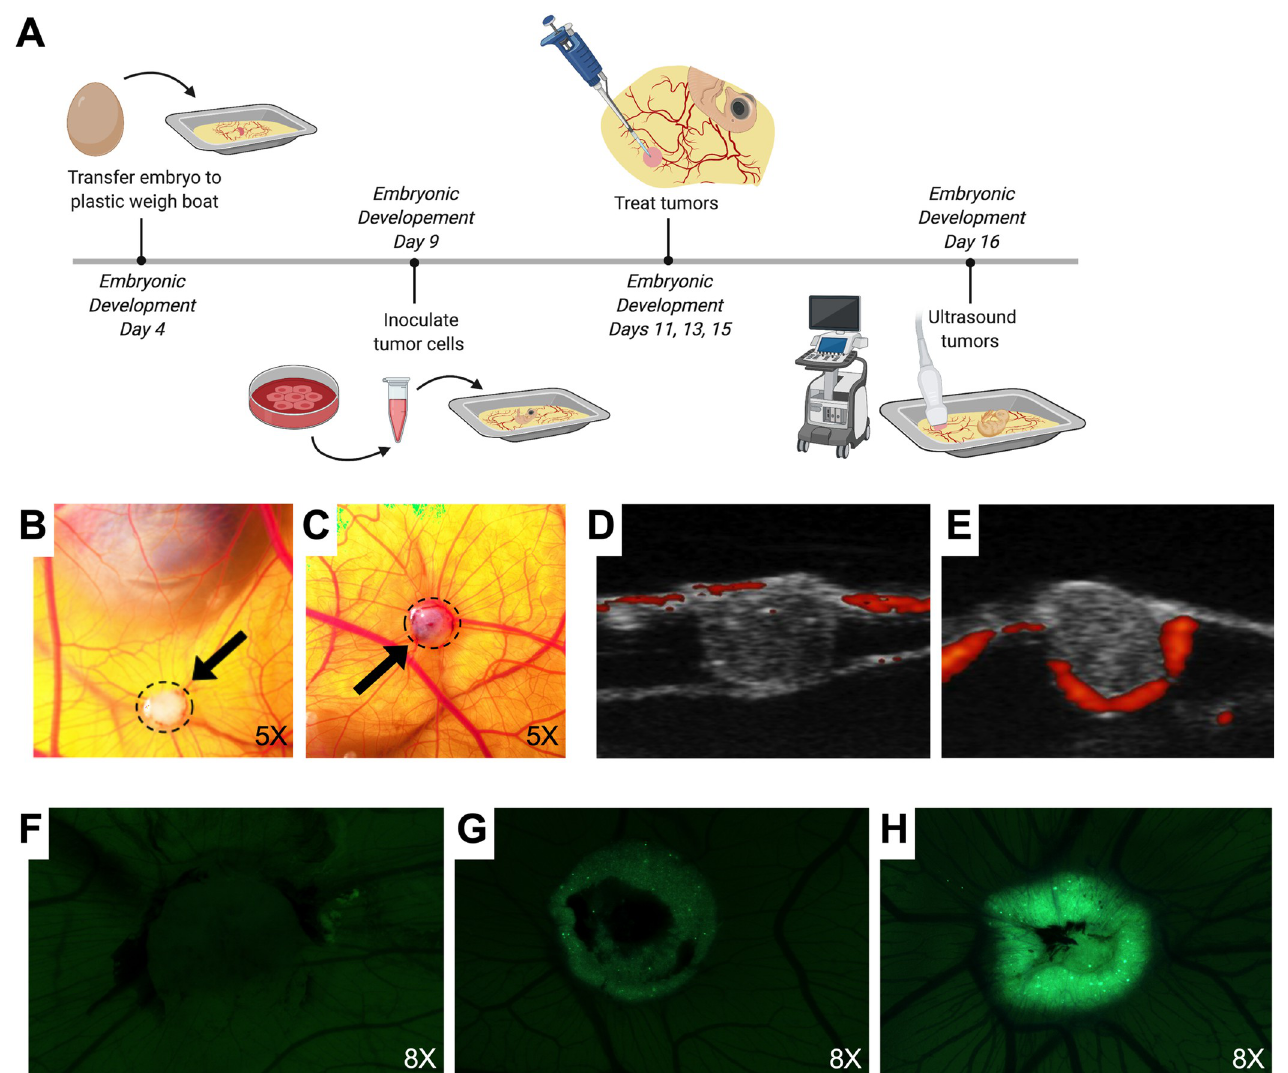
Fig 1. DIPG xenograft tumors are produced in the CAM model following inoculation with patient-derived cell lines. (A) Experimental procedures follow the corresponding timeline where 1x10 6 DIPG cells are inoculated onto the CAM on embryonic development day 9. DIPGIV (B) and DIPGXIIIp � (C) tumors (dashed perimeter and black arrow) are visible within 48 hours of inoculation. Ultrasound visualization using RF Power Doppler Mode of DIPGIV (D) and DIPGXIIIp � (E) tumors reveals that the tumors grow below the CAM surface with blood flow visible around the edges of tumor and within CAM (red fluorescence: active blood flow). DIPGIV tumor growth can be appreciated through visualization of increased GFP signal of tagged tumor cells from day 11 (F) to day 13 (G) to day 15 (H).